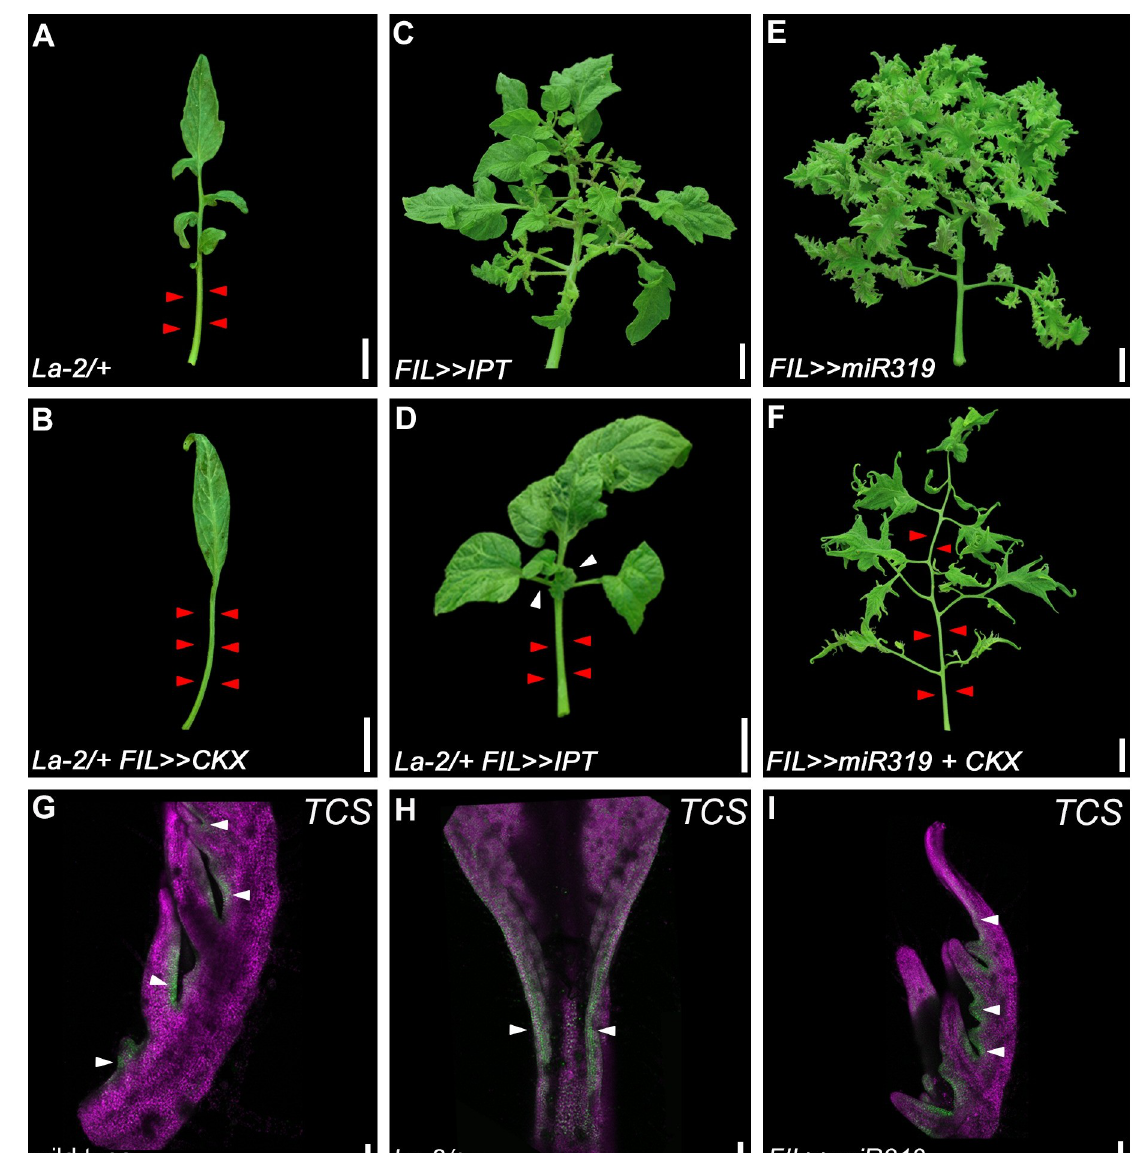
Fig 6. LA reduces leaf margin’s sensitivity to CK. ( A-F ) Phenotypes of leaves with increased CK ( FIL >> IPT ) or decreased CK ( FIL >> CKX ) levels, and increased LA activity ( La-2/+ ) or reduced LA activity ( FIL >> miR319) . All leaves depicted are fully expanded fifth leaves. Bars = 2 cm. White and red arrowheads represent primary leaflets and missing primary and intercalary leaflets, respectively. ( G-I ) Confocal micrographs of TCSv2 :: 3XVENUS in successive developmental stages in indicated genotypes. TCSv2 driven signals are reduced in La2/+ in the fifth plastochron. The pattern of VENUS expression was detected by a confocal laser scanning microscope (CLSM model SP8; Leica), with the solid-state laser set at 514 nm for excitation and 530 nm for emission. Chlorophyll expression was detected at 488nm excitation/ 700nm emission. Bars = 100